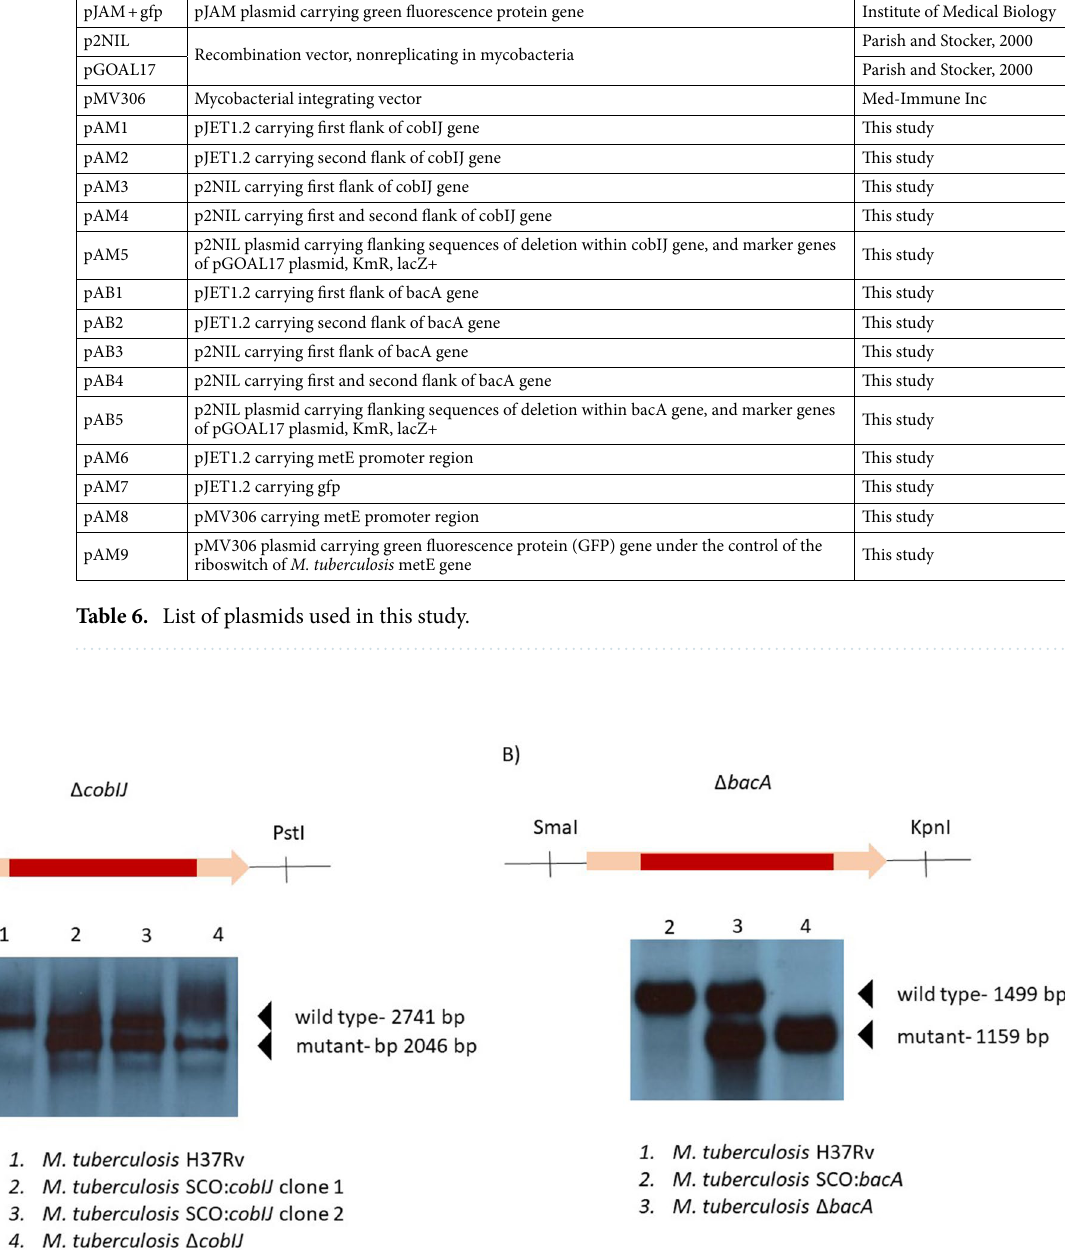
Figure 6. Southern blots confirming deletion of genes cobIJ and bacA in M. tuberculosis H37Rv. We used a gene replacement method through homologous recombination to obtain unmarked genetic mutants with large deletions inside the genes. Single cross-over (SCO) describes an intermediate step of mutagenesis. The images are cropped, hence altered lane numbering. Full-size images can be found in the supplementary